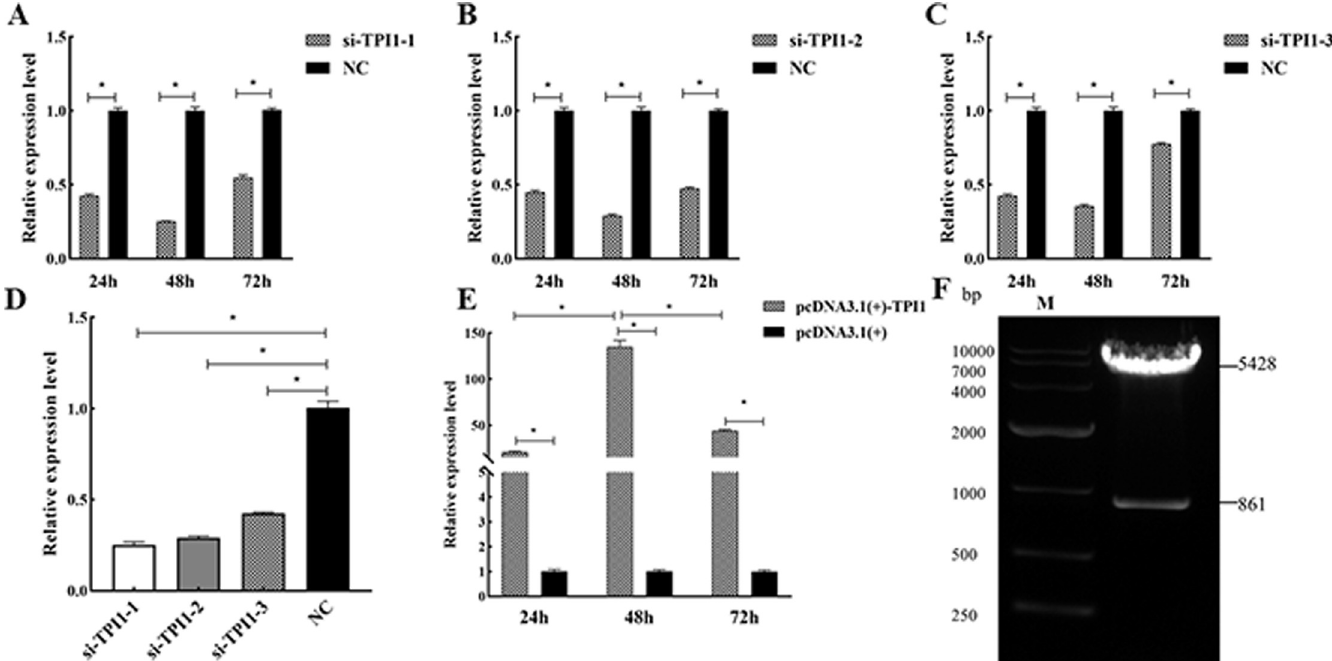
Fig 2. Evaluation of recombinant plasmid and detection of transfection efficiency. (A-E) TPI1 gene silencing or overexpression efficiency. (F) Evaluation of recombination plasmids. “ � ” indicate significant difference ( P < 0.05), the same below.